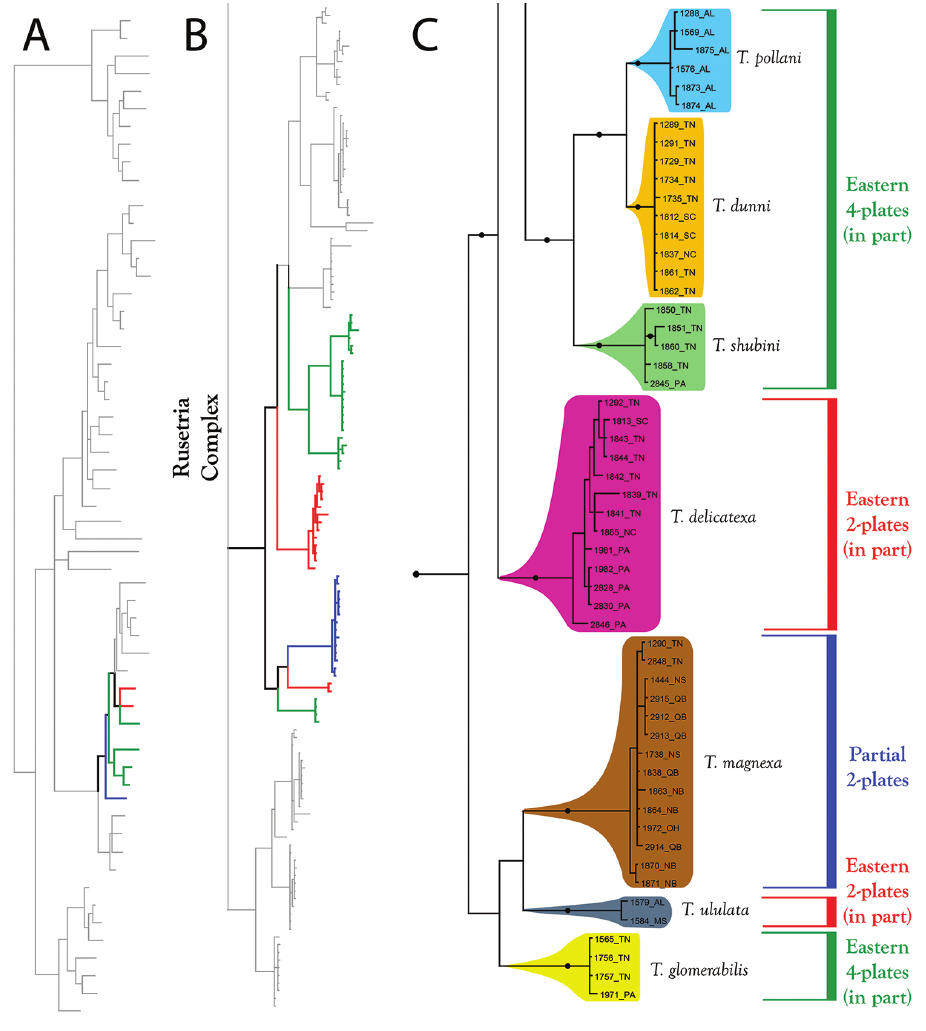
Figure 15. Rusetria Complex (part II). All species are eastern. Relationships among species groups re- main unresolved, except for three species ( T. dunni ; T. pollani ; and T. shubini ), which form a well-sup- ported clade in all analyses. A Species guide (overview of 28S+COI analysis from Figure 7–8) B Overview of Rusetria Complex from Figure 9 (COI-only analysis from Figure 9) C Detail of Rusetria Complex (in part) from B C Detail of Rusetria Complex (in part) from Figure 9. Colored lineages in A and B corre- spond to Group names and brackets in C. Dots denote posterior probably of greater than 95%. Taxa are displayed by DNA number and state (U.S.) or territory (Canada)